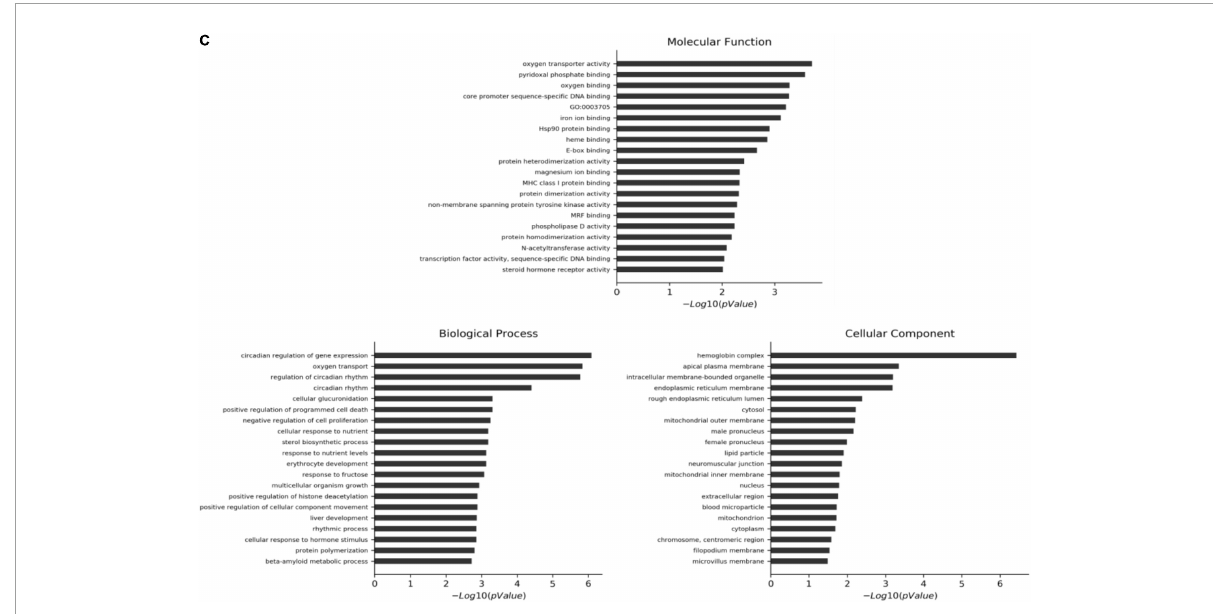
FIGURE3 First 20 GO items with significant enrichment of differential genes in each plate. (A) CF group vs. model control group. (B) Luteolin group vs. model control group. (C) Luteoloside group vs. model control